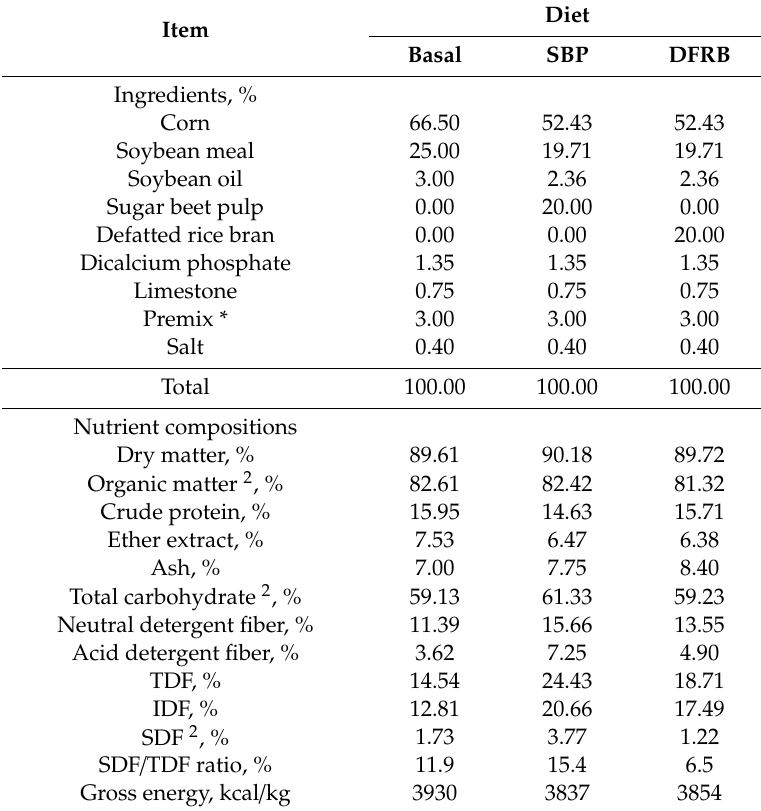
Table 2. Ingredients and analyzed nutrient compositions of the experimental diets (as-fed basis) 1